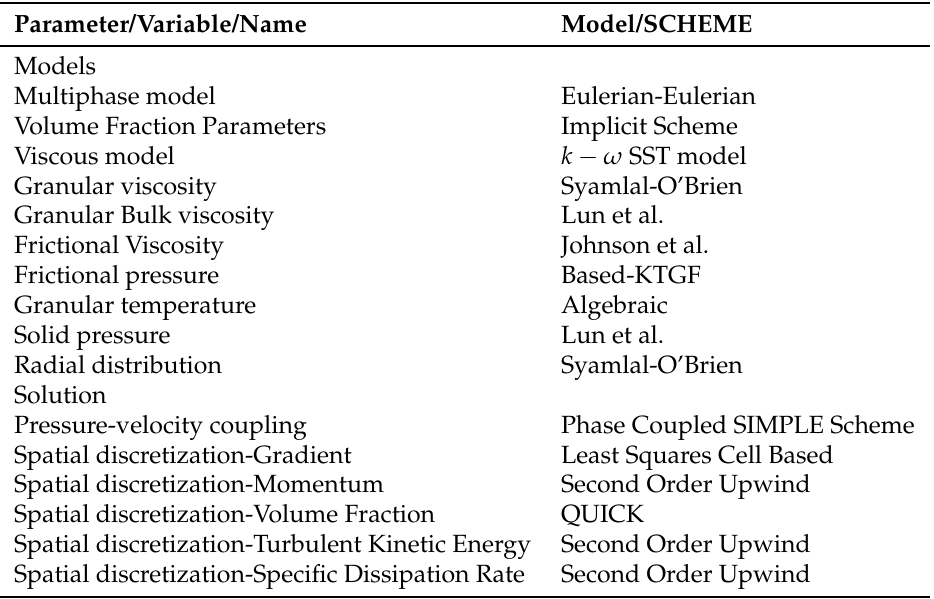
Table 3. List of numerical models and